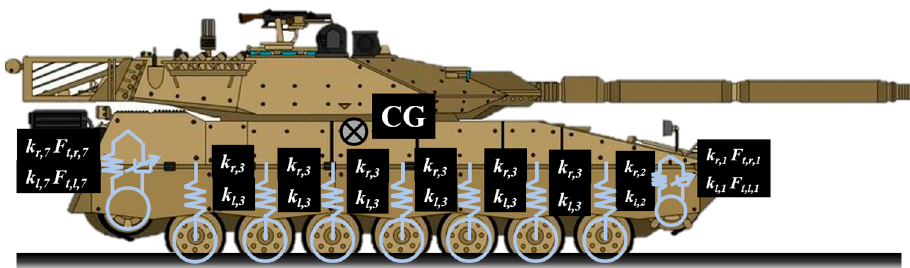
Figure 11. Model of the 2S1 military vehicle [156].